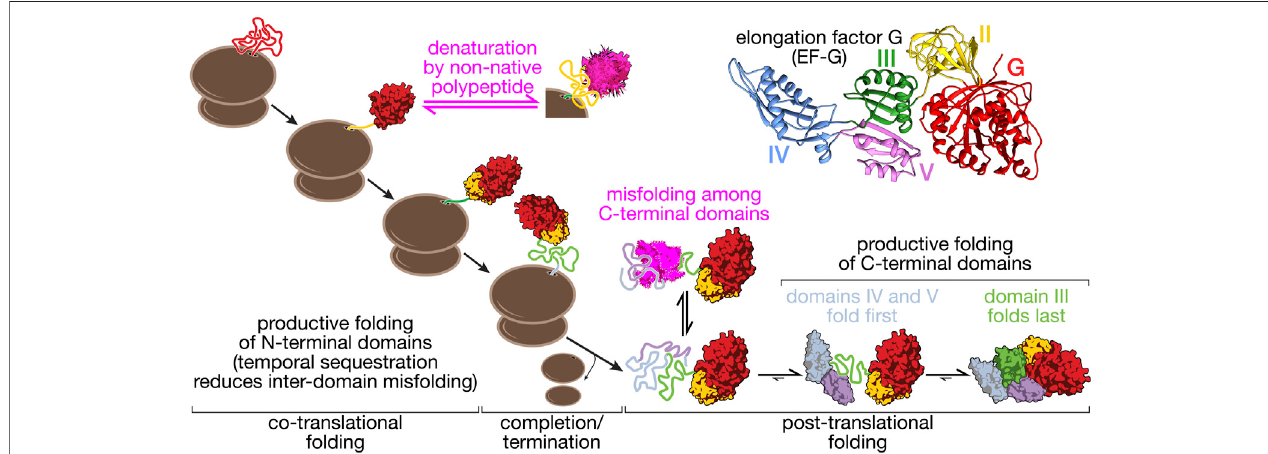
FIGURE2| Foldingpathway ofelongation factorG(EF-G).EF-Gisa fi ve-domain protein(structure,topright:pdb4v9p)thatillustratessomeofthecoreaspectsof multi-domain protein folding. The N-terminal domains (G, II) fold co-translationally, with G-domain folding being a prerequisite for domain II folding. Productive folding competes with denaturation of the G-domain through interactions with unfolded domain II. This complication of co-translational folding is mitigated by a nascent chain- bindingchaperone(Liuetal.,2019a).BecausedomainIIIrequiresstabilizingcontactswithdomainsIVandV,co-translationalfoldingisdisrupted.Post-translational folding of the C-terminal domains (III – V) results in the accumulation of unfolded polypeptide during EF-G synthesis that has a high propensity to form off-pathway misfolded states (Liu et al., 2019b). EF-G thus provides an example of how overall folding pathways are shaped by domain interactions in large